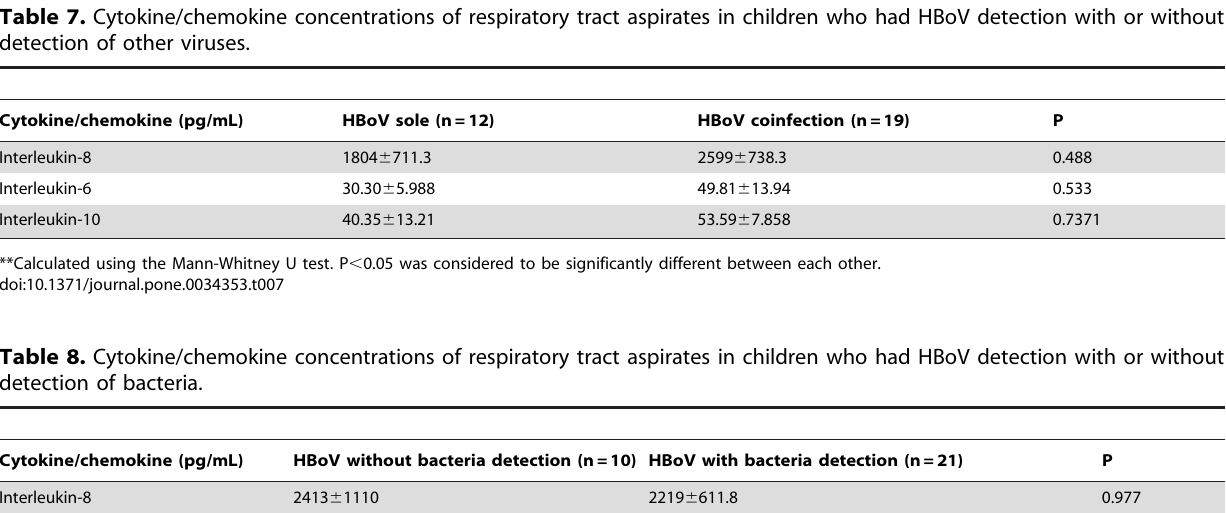
Cytokine/chemokine (pg/mL)